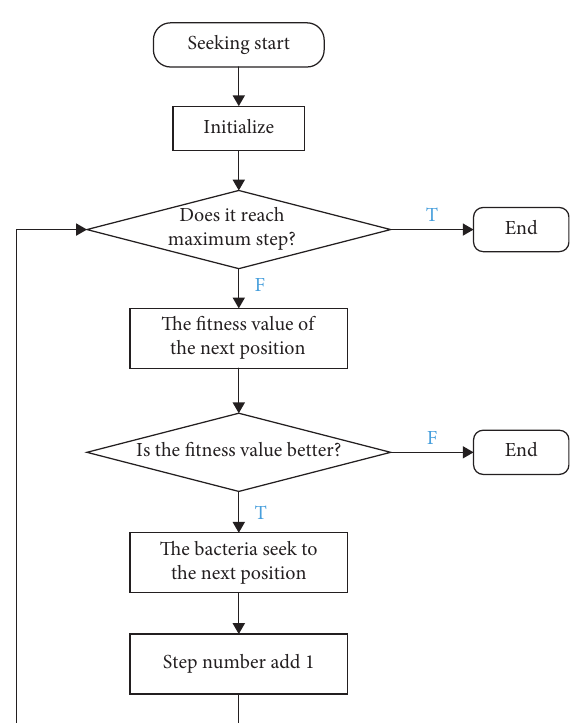
Figure 3: Seeking better fitness value ahead of time for